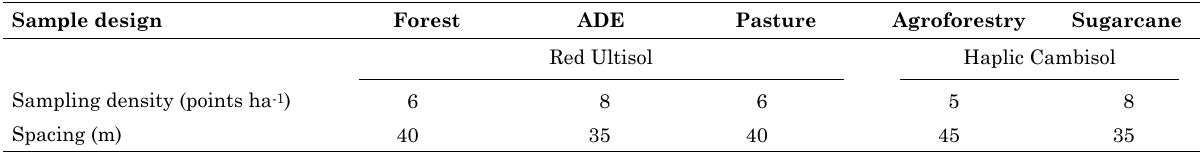
Table 3. Minimum sampling density and spacing based on the range estimated by scaled semivariograms for soil chemical properties in different environments studied in southern